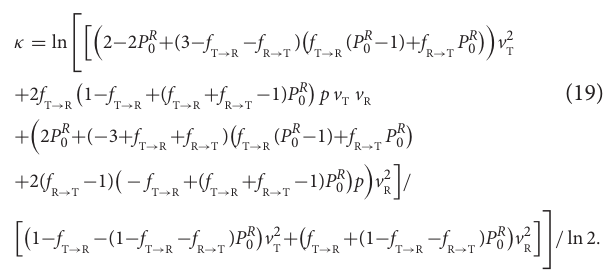
FIGURE 4 | (A) Asymptotic diffusion coefficient D asymp as a function of the run persistency p for v R = 10, v T = 1, 1 t = 1, f space of transition probabilities f